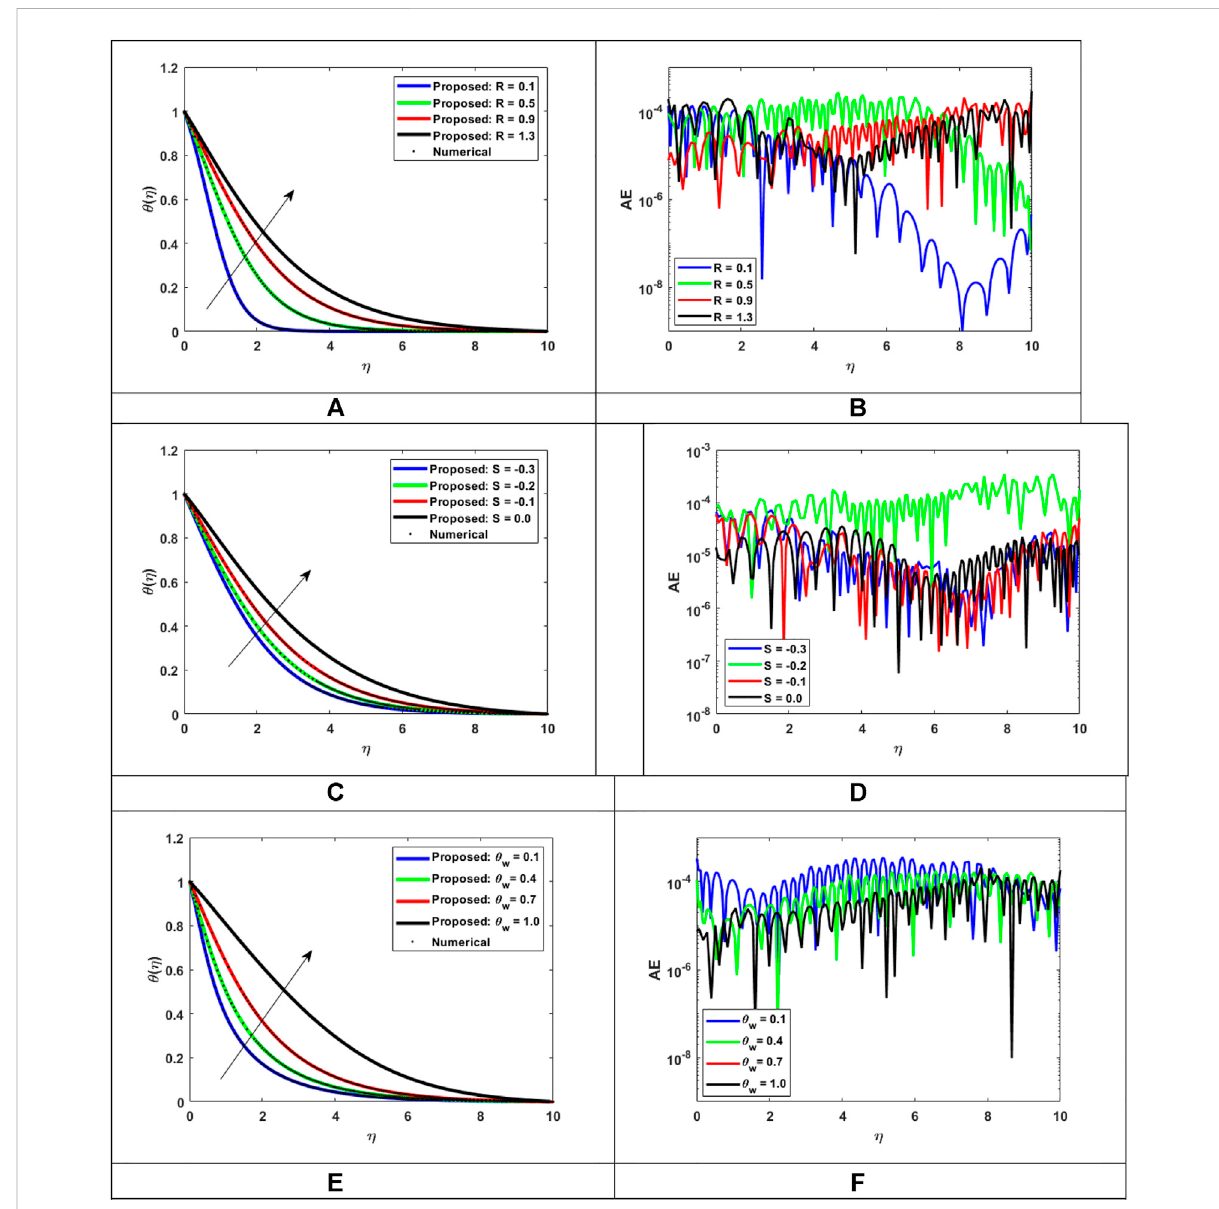
FIGURE 14 AssessmentofLMLA-BPNN alongthereferencedatasetofMHD-WNF-HGA. (A) Variationof R for θ ( η ) , (B) AEforMHD-WNF-HGA, (C) Variation of S for θ ( η ) , (D) AE for MHD-WNF-HGA, (E) Variation of θ w for θ ( η ) , (F) with AE for